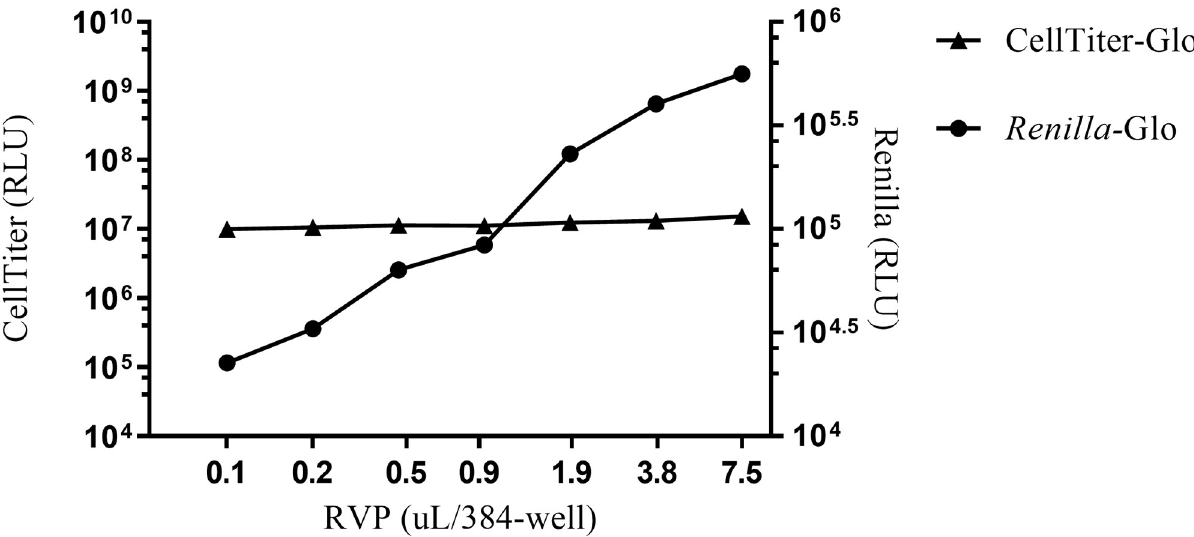
Fig 2. Viability and infectivity assessment for Z-RVP lot 229A. The CellTiter-Glo (RLU) response is displayed on the left y-axis and the Renilla -Glo (RLU) response is shown on the right y-axis. The CellTiter-Glo RLU expressed by the cells was consistent over Z-RVP amount tested whereas the Renilla -Glo (RLU) increases as the Z-RVP amount